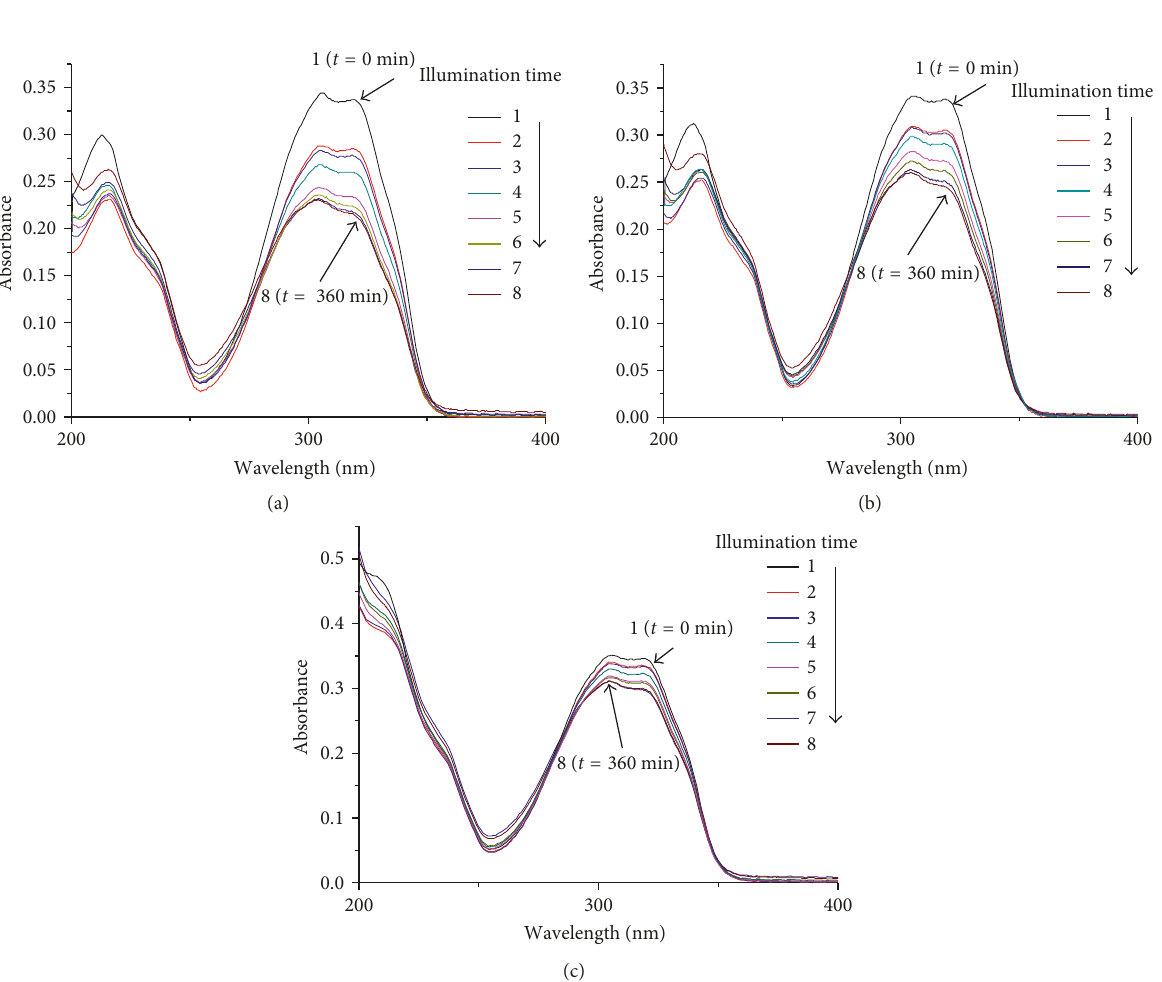
Figure 5: UV absorption spectra of aqueous solutions of three different solutions irradiated over 360min: (a) the solution of resveratrol (Res), (b) the solution of inclusion complexes (CD+ Res), and (c) the solution of conjugate (CDRes).